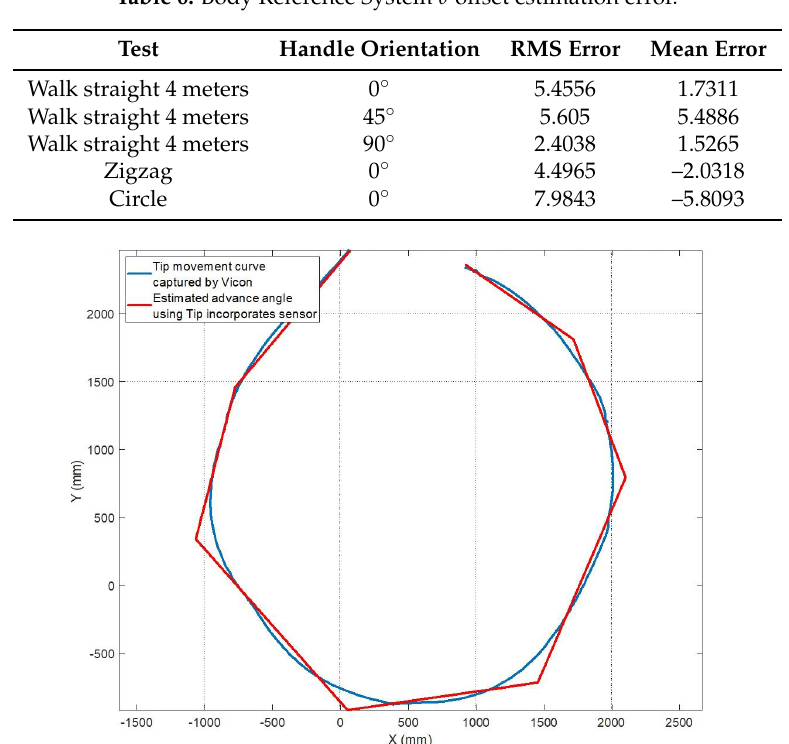
Table 6. Body Reference System θ offset estimation error.